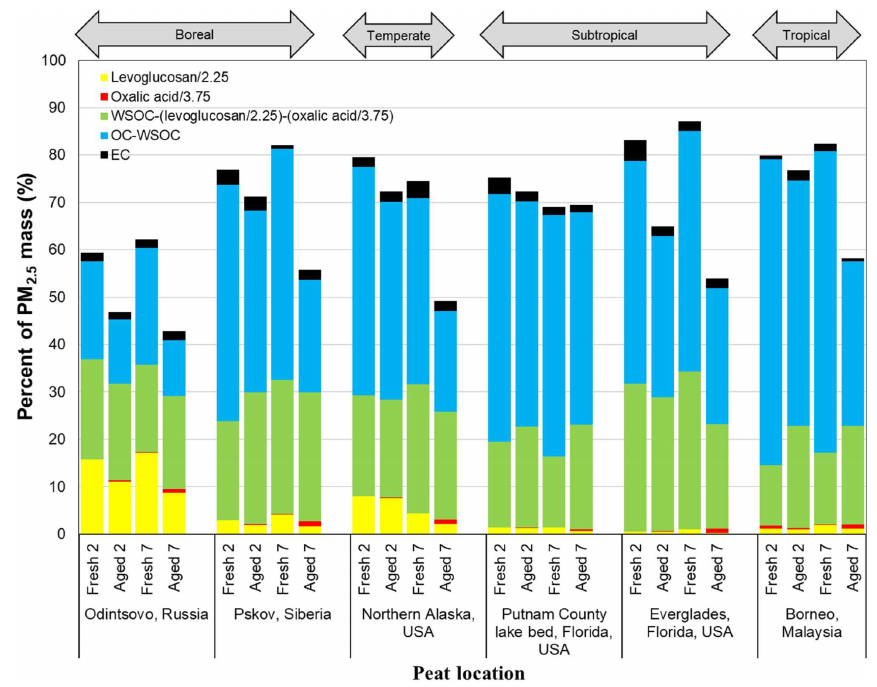
Figure 4. Abundances of fresh and aged carbon-containing components in PM 2 . 5 . Levoglucosan (C 6 H 10 O 5 ) is divided by 2.25 and oxalic acid (C 2 H 2 O 4 ) is divided by 3.75 to obtain the carbon content. These levels are subtracted from the water-soluble organic carbon (WSOC) to obtain the remainder, and WSOC is subtracted from organic carbon (OC) to obtain non-soluble carbon. Elemental carbon (EC) is unaltered.